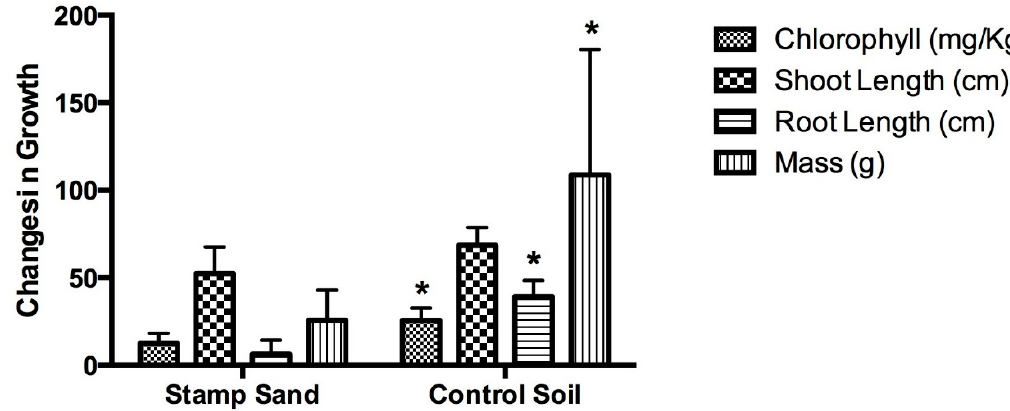
Figure 1. Effect of stamp sand on the growth of vetiver grass compared to control soil. Error bars represent standard deviation with n = 6. Statistical significance was determined using Welch’s t -test and with α = 0.05. (*) denotes p -value < 0.05.